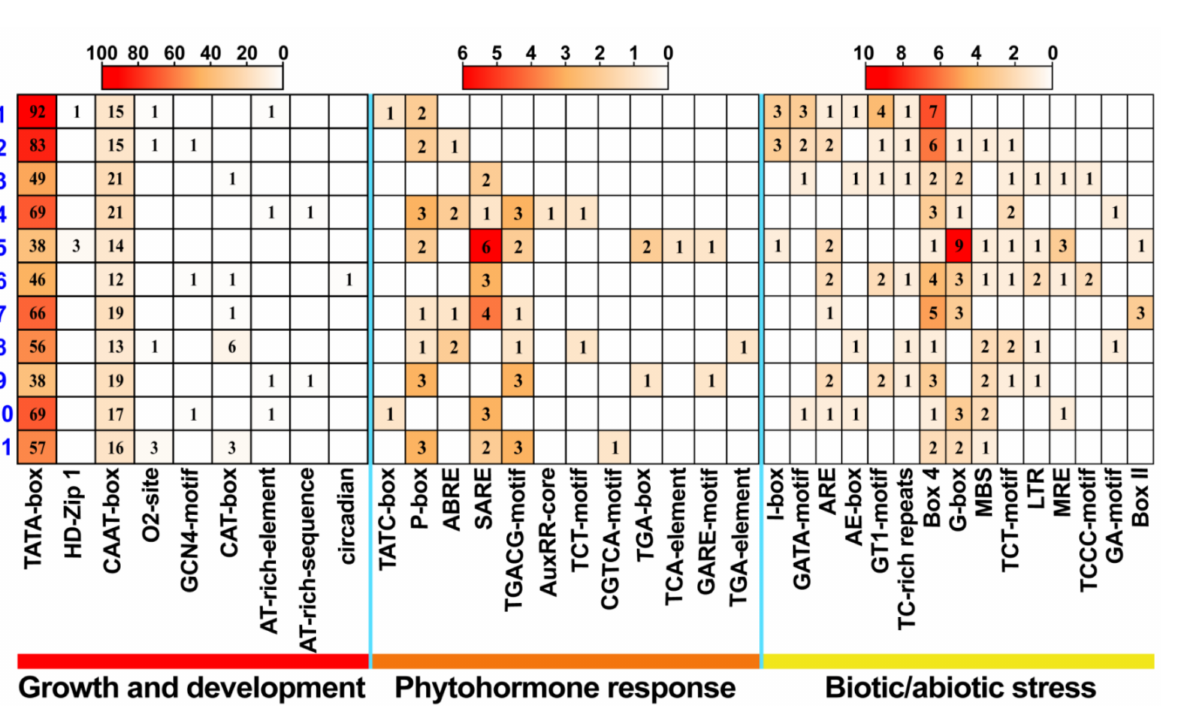
Figure 6. The promoter sequences of the 2000 bp upstream region of the start codon of the StMTP s were analyzed using Plantcare. The abscissa represented the type of promoter, and the ordinate represents the specific gene. The blue numbers 1–11 indicate StMTPs 1–11 . All promoters can be divided into three categories: growth and development, plant hormone response, and biotic/abiotic